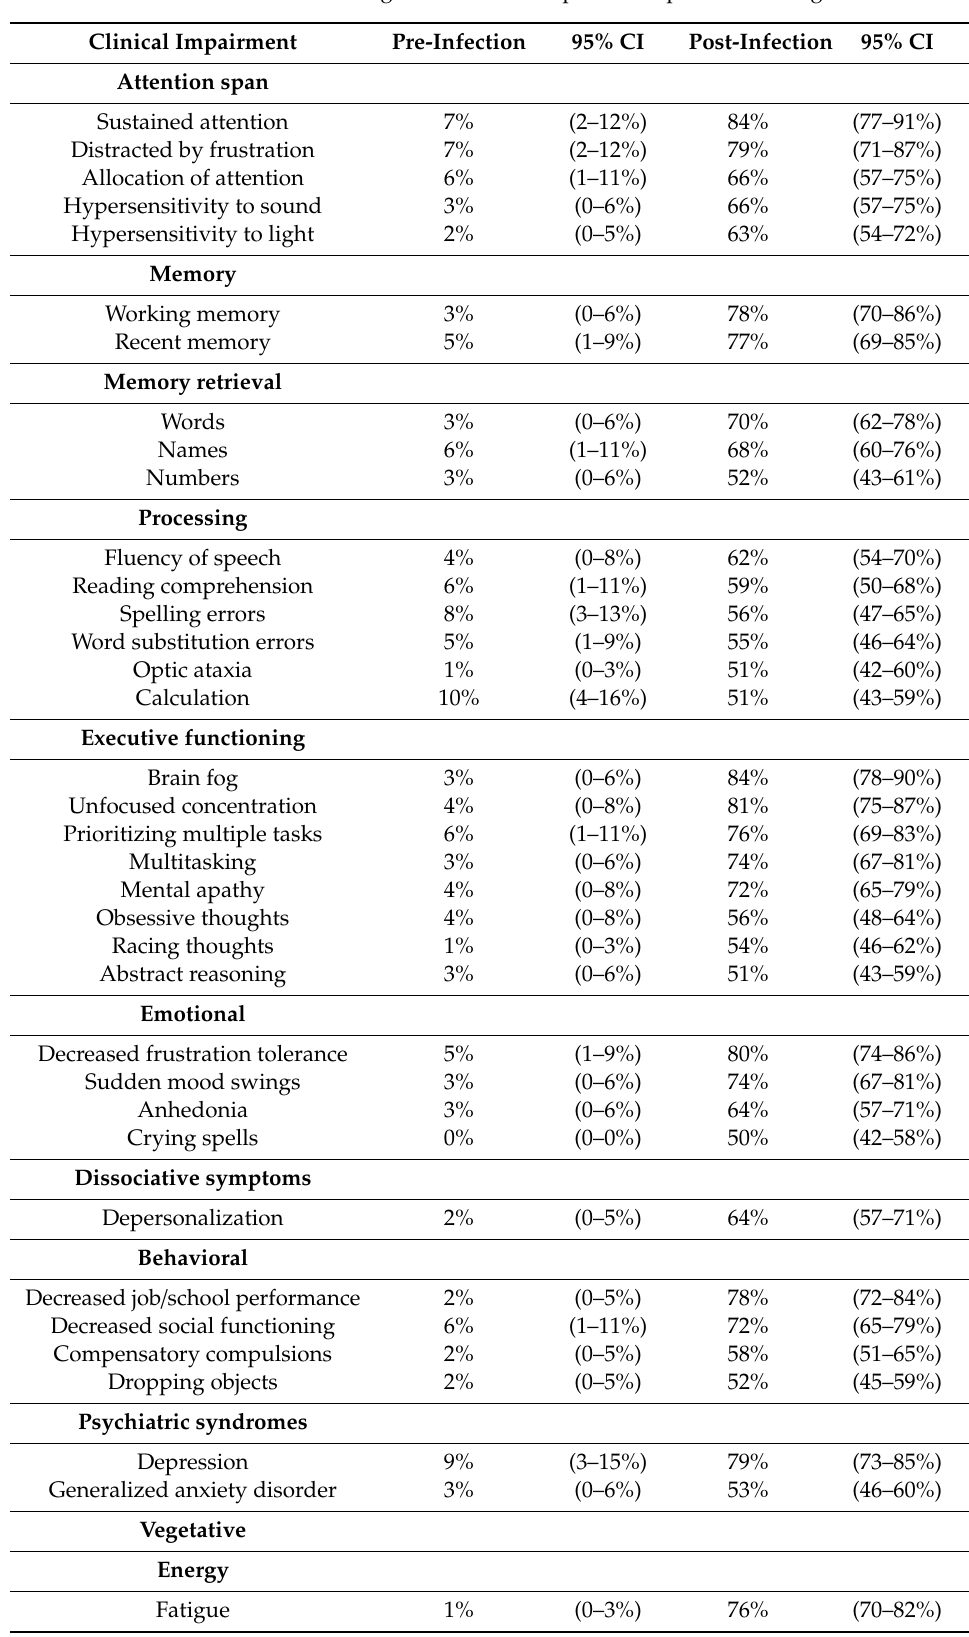
Table 3. Clinical findings where ≥ 50% of patients report the